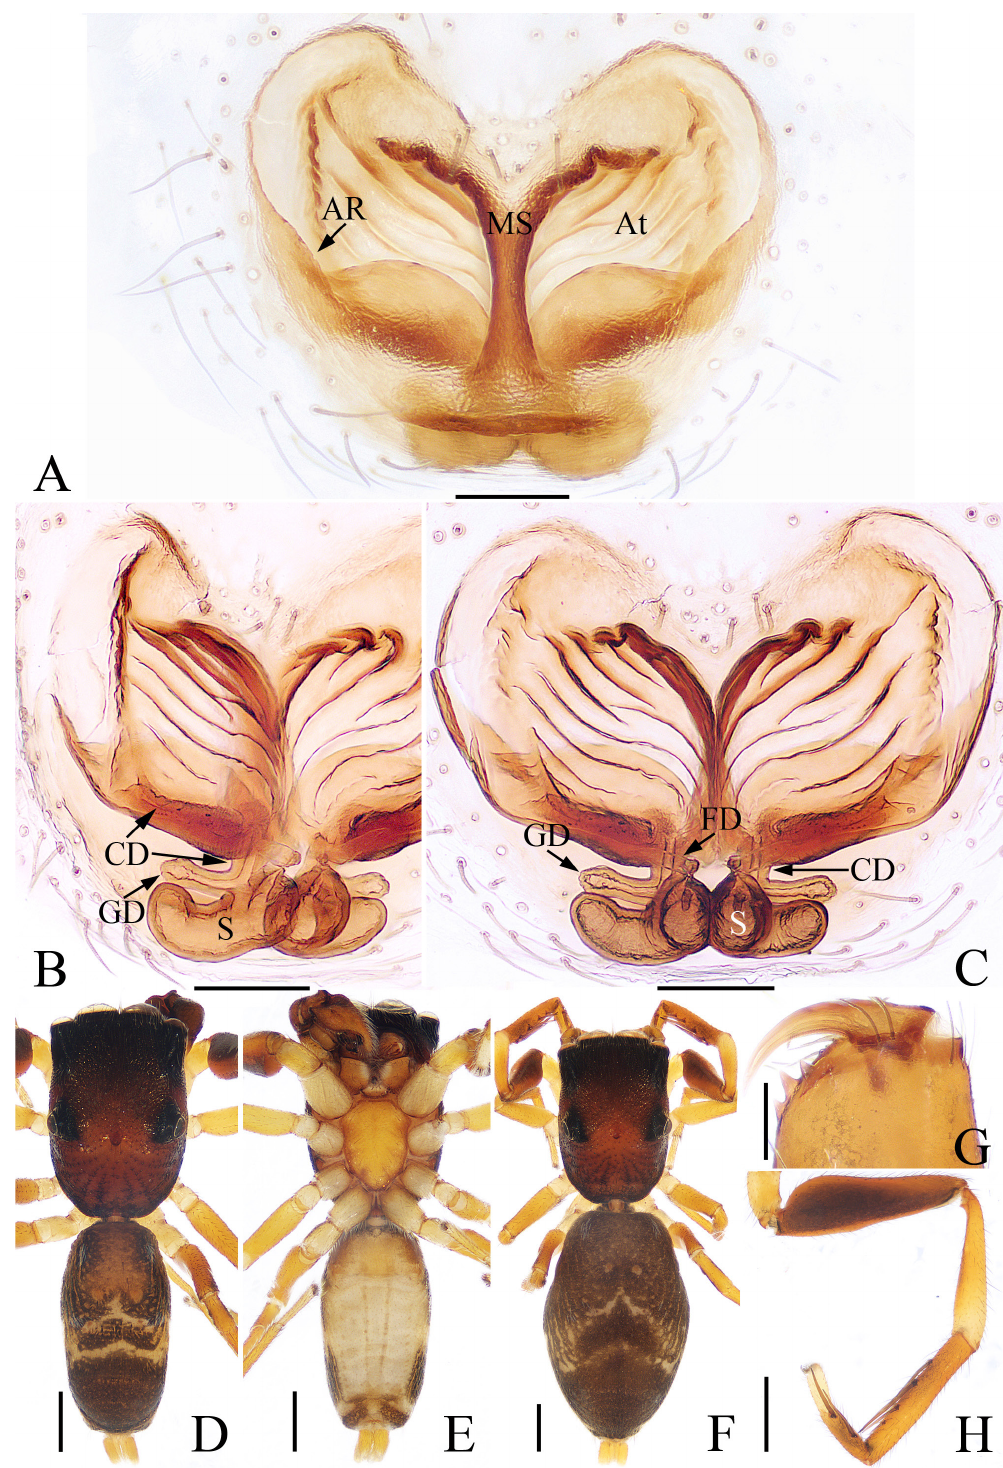
Fig. 12. Synagelides subgambosus sp. nov. A–C, F . Paratype, ♀ (TRU-Salticid-0032). D–E, G–H . Holotype, ♂ (TRU-Salticid-0028). A . Epigyne, ventral view. B . Epigyne, dorsolateral view. C . Epigyne, dorsal view. D . Habitus, dorsal view. E . Habitus, ventral view. F . Habitus, dorsal view. G . Chelicerae, dorsal view. H . Leg I, prolateral view. Abbreviations: see Material and methods. Scale bars: A–C, G = 0.1 mm; D–F, H = 0.5